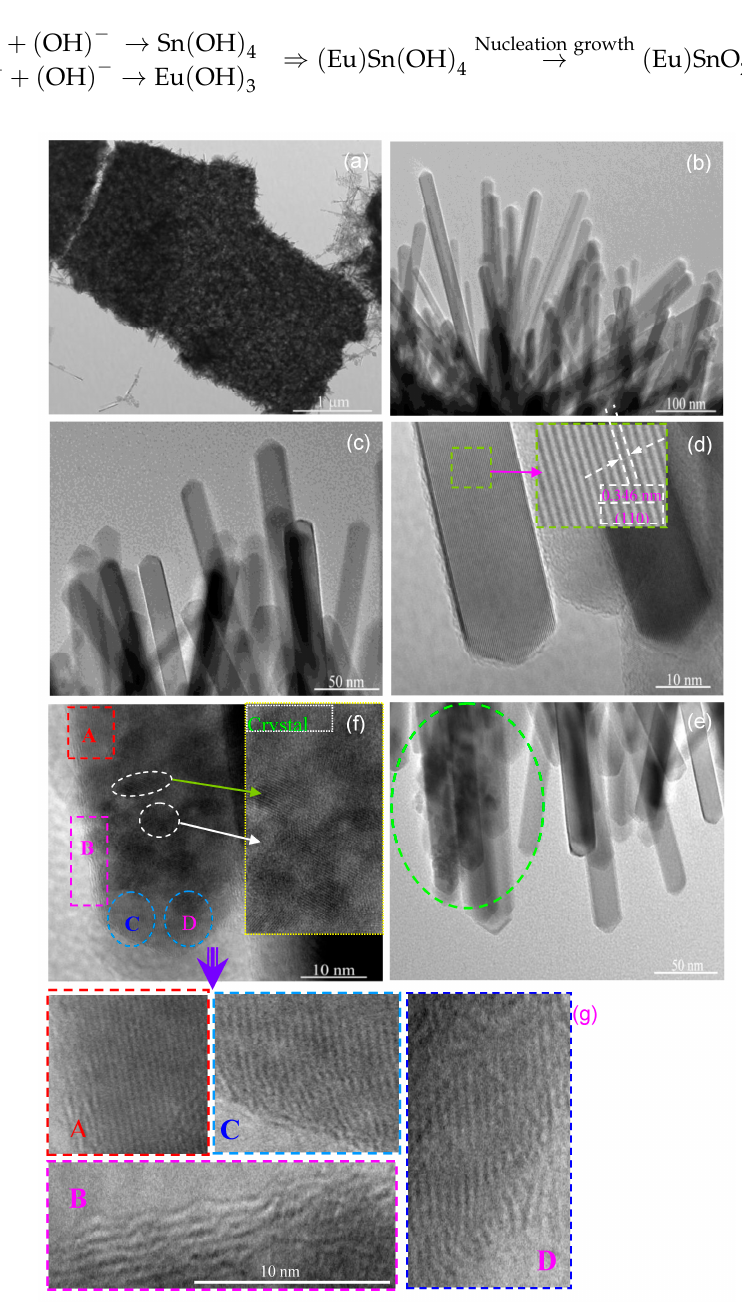
Figure 4. TEM images of 0.5 at % Eu-doped SnO 2 nanorod array: ( a ) Low magnification TEM image of a section nanorods arrays; ( b ) Top TEM image of nanorods arrays; ( c ) High magnification TEM image of individual nanorods; ( d ) HRTEM image of an individual Eu-doped SnO 2 nanorod. Inset: an enlarge lattice fringes; ( e ) TEM image of defective nanorods; ( f ) HRTEM image of an individual defective SnO 2 nanorod adhered by crystal grains and marked as A, B, C, and D area, respectively. Inset: an enlarge lattice fringes of crystal grains; ( g ) Enlarge HRTEM image of the marked area A, B, C, and D showing twists and turns, distorted, and discohered lattice fringes, accordingly.